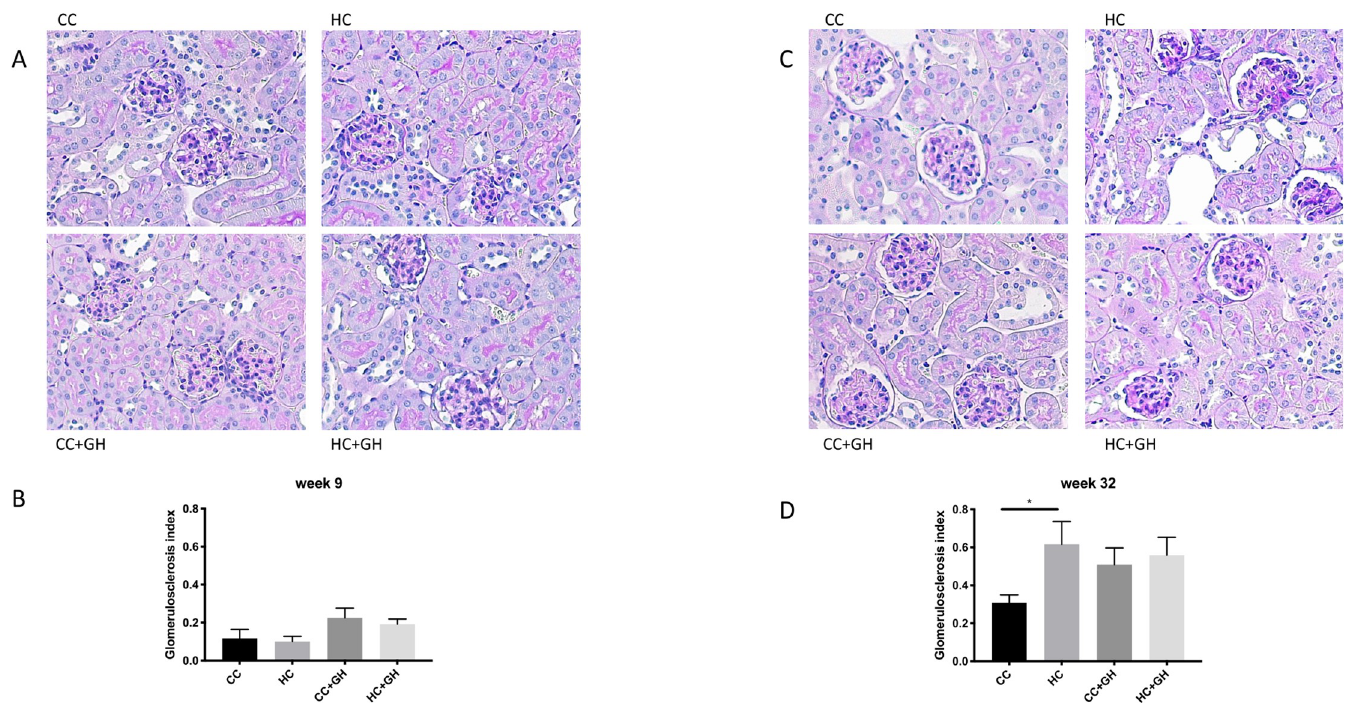
Fig 3. Glomerulosclerosis. (A, B) Week 9 offspring representative images of PAS staining for glomerulosclerosis at 400x magnification, and glomerulosclerosis index, (C, D) week 32 offspring representative images of PAS staining for glomerulosclerosis at 400x magnification, and glomerulosclerosis index. Results expressed as mean ± SEM, n = 6. � p <